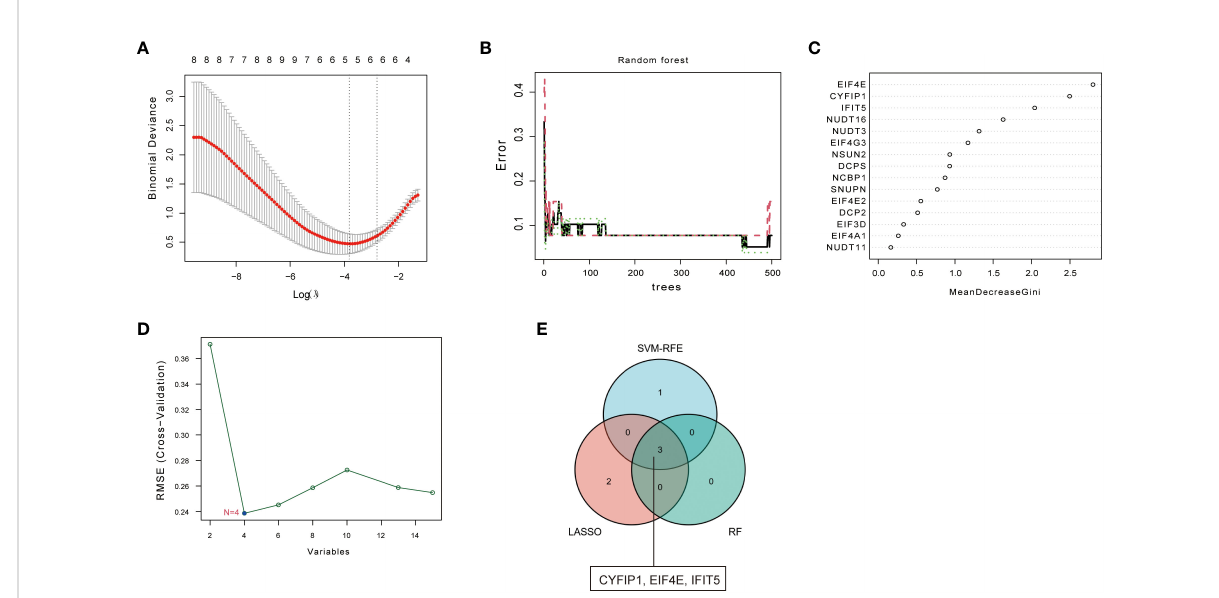
FIGURE 2 Screening of disease signature genes. (A) Selection of the best Log ( ʎ ) value for LASSO regression. The x-axis represents the Log ( ʎ ) value, and the y-axis represents the error rate of cross-validation errors. (B) The in fl uence of the number of decision trees on the error rate. The x-axis repre- sents the number of decision trees, and they-axis indicates the error rate. (C) Results of the Ginico ef fi cient method in random forest classi fi er. The x-axis indicates the genetic variable, and the y-axis represents the importance index. (D) Variation curve of gene cross-validation error in SVM-RFE algorithm. (E) Venn diagram showing 3 disease signature genes shared by LASSO, SVM-RFE and RF arithmetic